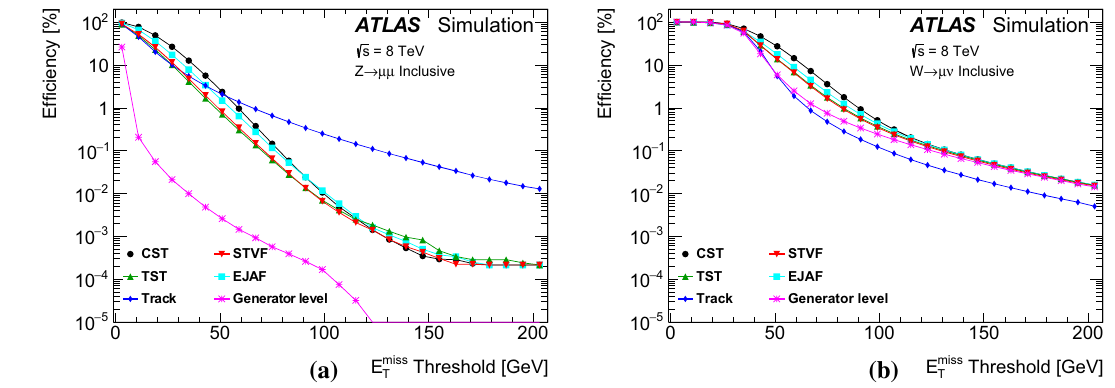
Fig. 15 The selection efficiency is shown versus the E miss